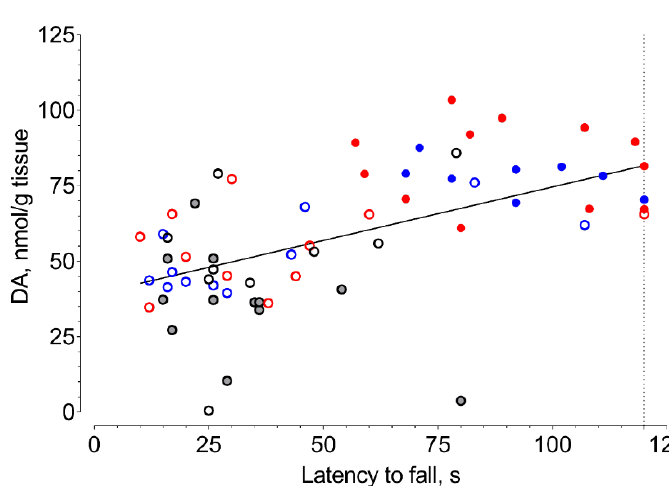
Figure 6. Correlation between striatal dopamine content of 6-OHDA-lesioned mice and their latency to fall in a fixed-speed rotarod test (FSRR). Gray dot —vehicle. Black circle —BD-1047 3.0 mg/kg. Red dot —afobazole 2.5 mg/kg. Blue dot —PRE-084 1.0 mg/kg. Red circle —BD-1047 3.0 mg/kg and afobazole 2.5 mg/kg. Blue circle —BD-1047 3.0 mg/kg and PRE-084 1.0 mg/kg. R = 0.6, p < 0.0001; line of best fit equation DA = 0.3518*X + 39.11.